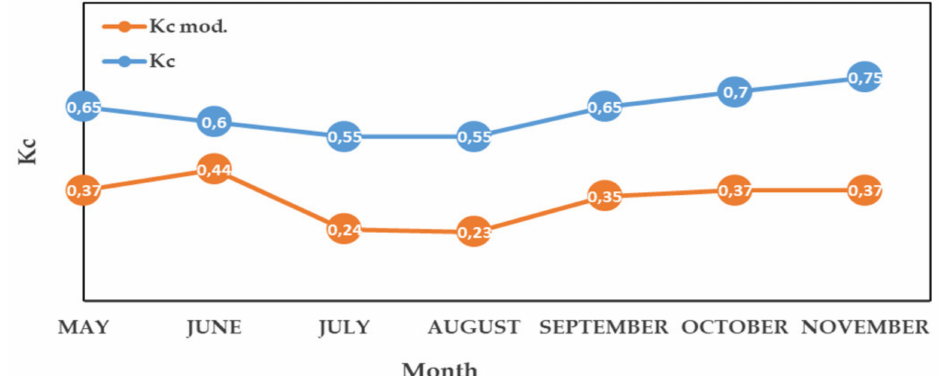
Figure 4. Crop coe ffi cient (Kc) values according to the physiological state of the olive grove. Kc was adjusted to the crop conditions of Extremadura and was calculated with the Orgaz et al. [47] method using the 10-year average, and Kc mod. was adapted to the deficit irrigation strategy.